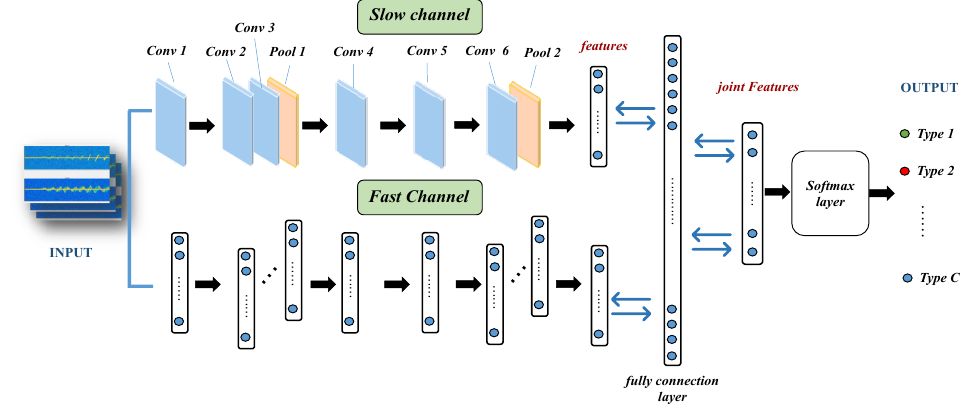
Figure 7. CNN classification flow chart.